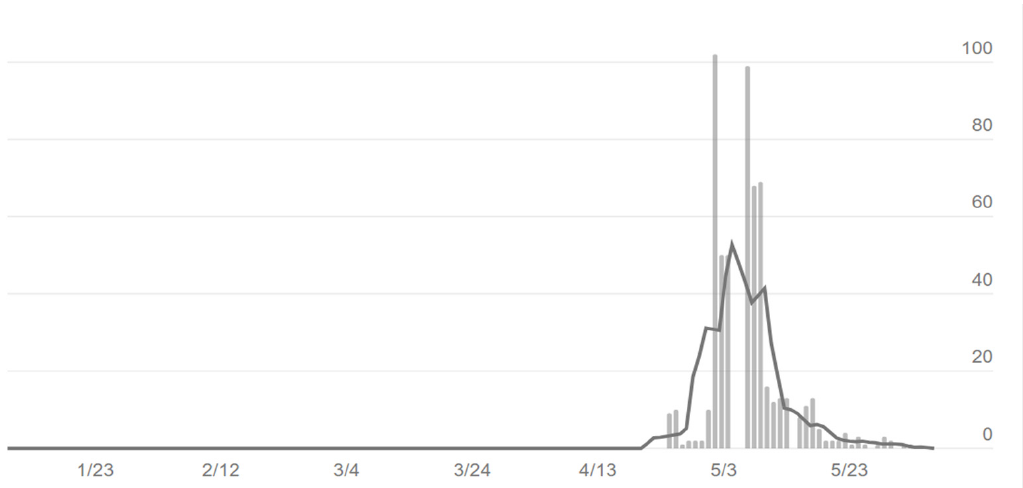
Figure 4. Confirmed cases of COVID-19 in Wuhan in 2020 (Wuhan CDC).